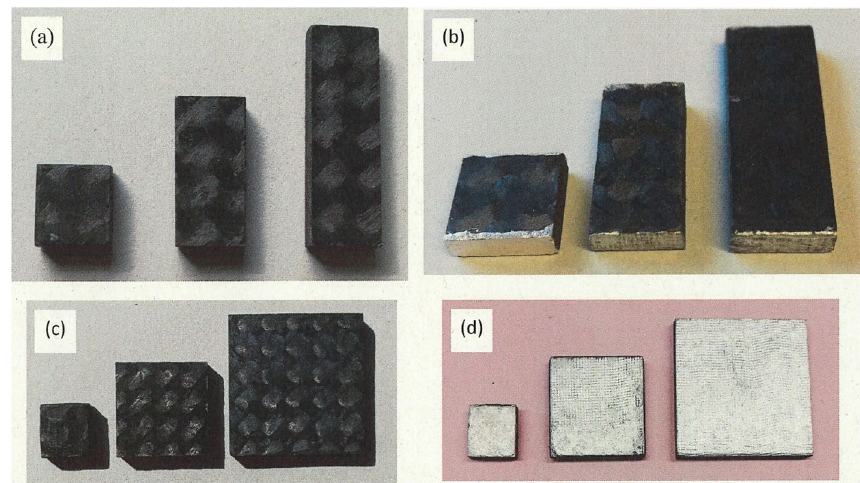
Fig. 1 Electrical conductivity measurement specimens a unpainted in in-plane direction, b painted in in-plane direction, c unpainted in through-the-thickness direction, and d painted in through-the-thickness direction